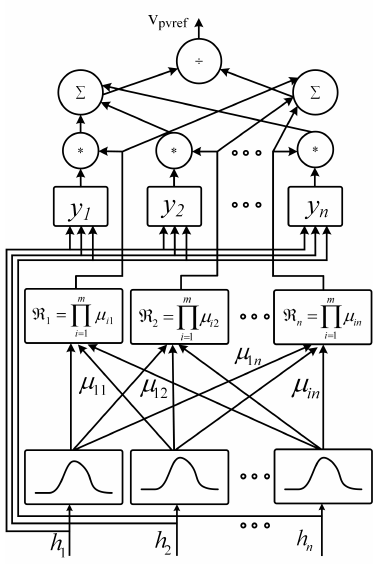
Figure 2. NeuroFuzzy architecture.